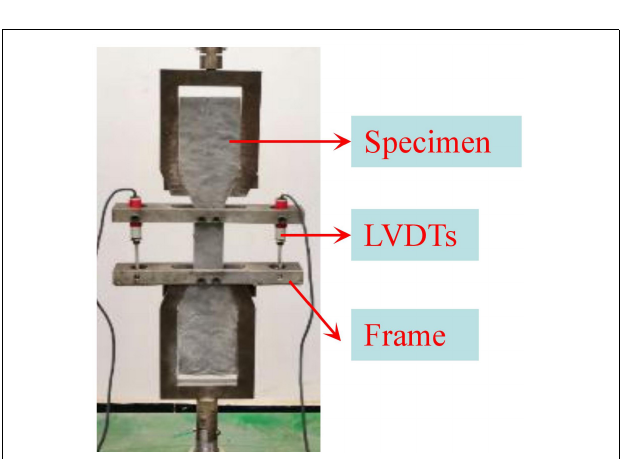
FIGURE 4 | Test setup of uniaxial tensile test.